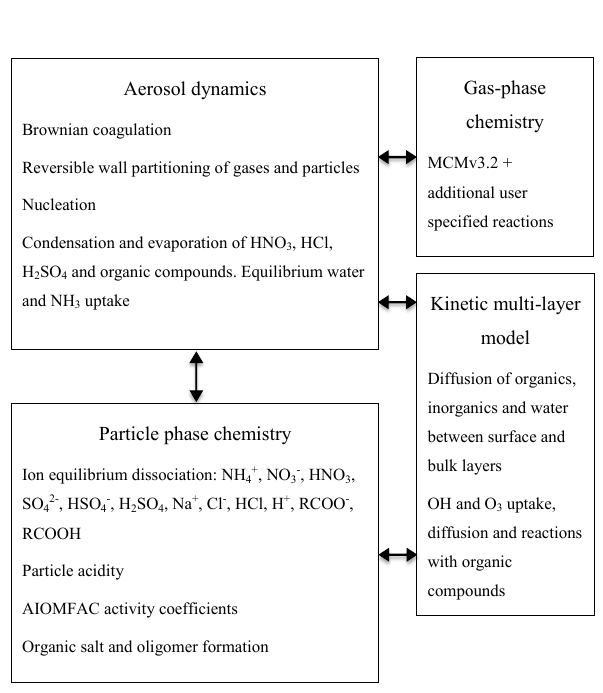
Figure 1. Schematic picture of the ADCHAM model